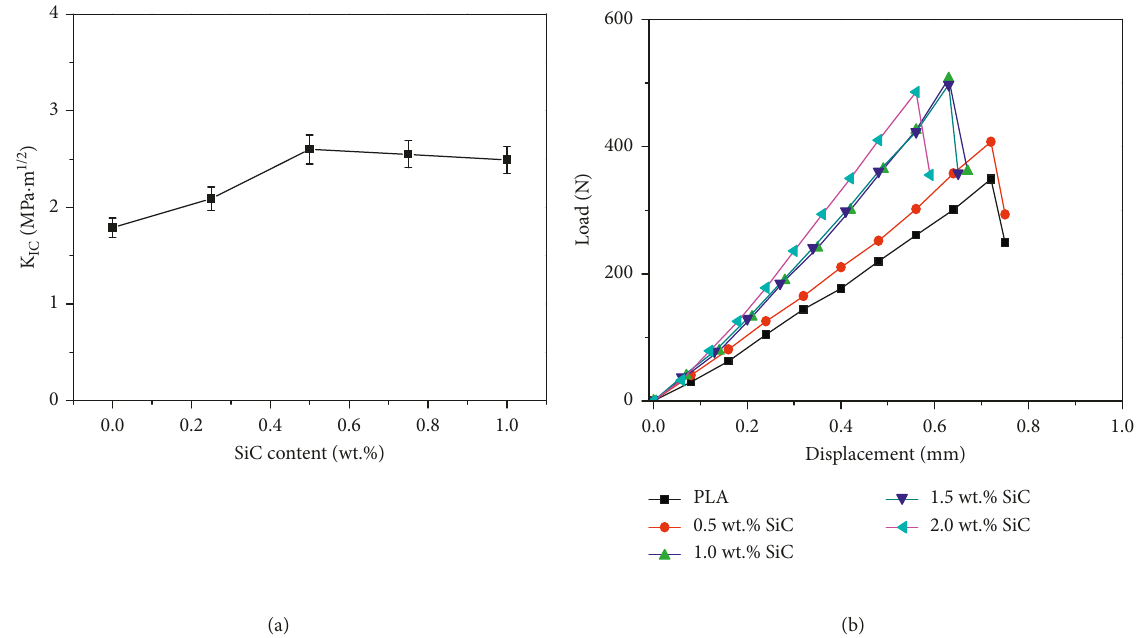
Figure 6: Fracture toughness of PLA/PCL/SiC composites as a function of SiC